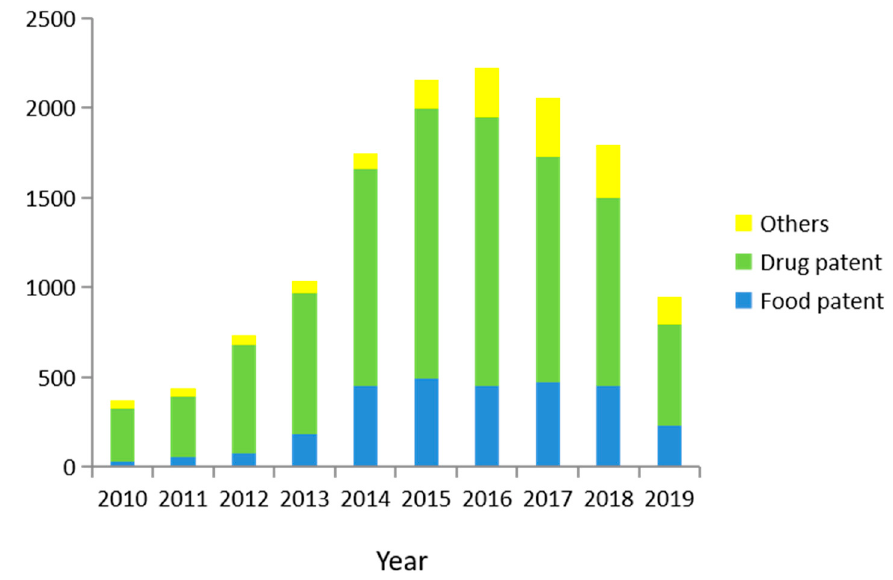
Figure 6. Patent statistics of P. grandiflorus from 2010 to 2019.